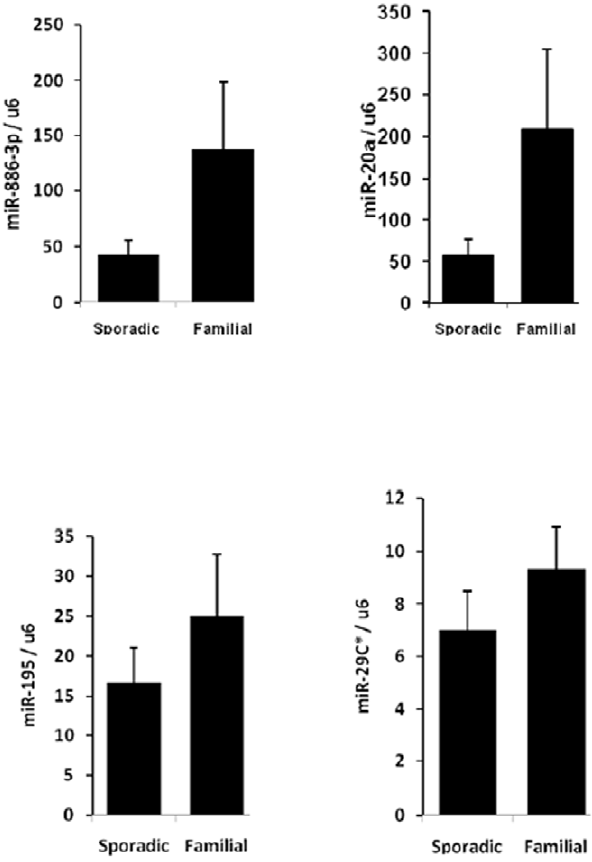
Figure 2. Validation of dysregulated miRNAs in sporadic versus familial papillary thyroid cancer by quantitative RT-PCR. MiR- 20a was 4-fold and miR-886-3p was 3-fold higher in familial papillary thyroid cancer as compared to sporadic (p=0.025 for miR-20a, p=0.028 for miR-886-3p, p=0.37 for miR-195, p=0.46 for miR-29c). Values are average expression plus and minus the standard error of mean. The Y axis represents the ratio of miRNA and U6 RNA using 2 2 DD Ct method, and the lowest value of the sample was set to 1.0.